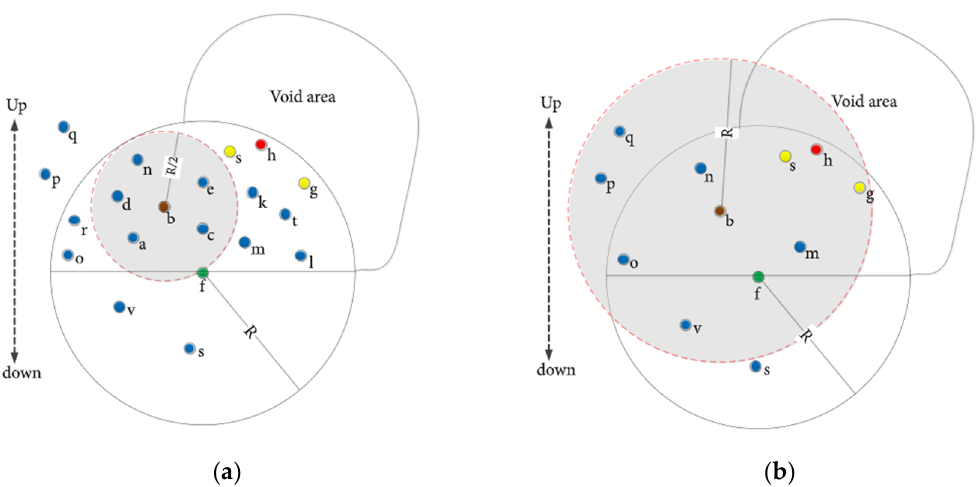
Figure 12. ( a ) Forwarding area in a high density network, ( b ) Forwarding area in a low density network [51].